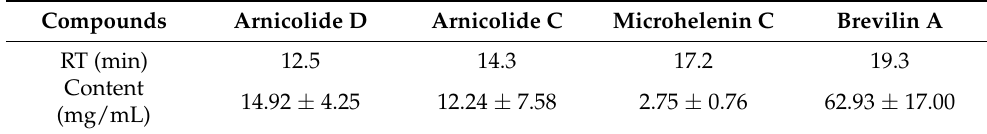
Table 1. Contents of Arnicolide D, Arnicolide C, Microhelenin C, and Brevilin A in CMX. Compounds